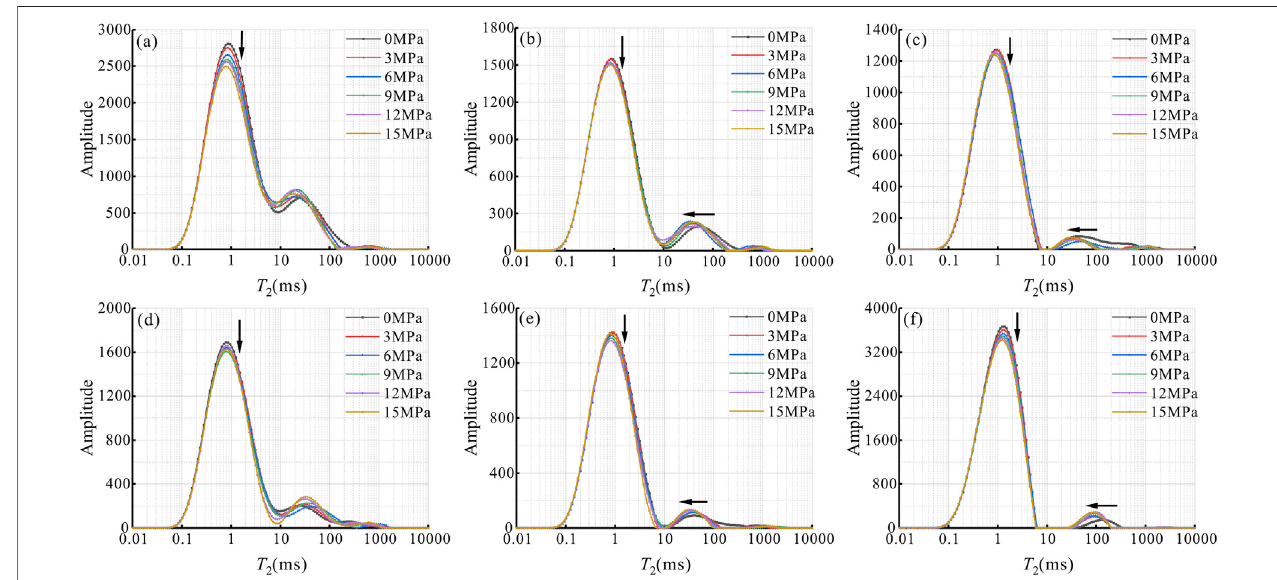
FIGURE 6 | T 2 spectra of samples under different con fi ning pressures.